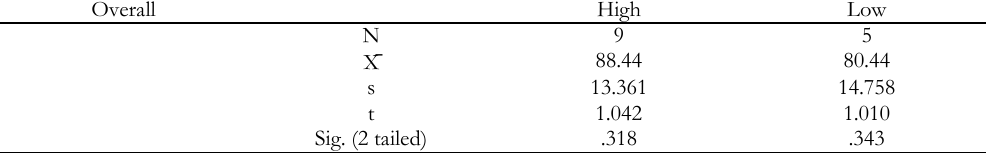
TABLE 4. Independent T-test for Overall Metacognitive Writing Strategies Overall High Low N 9 5 X ̄ 88.44 80.44 s 13.361 14.758 t 1.042 1.010 Sig. (2 tailed) .318